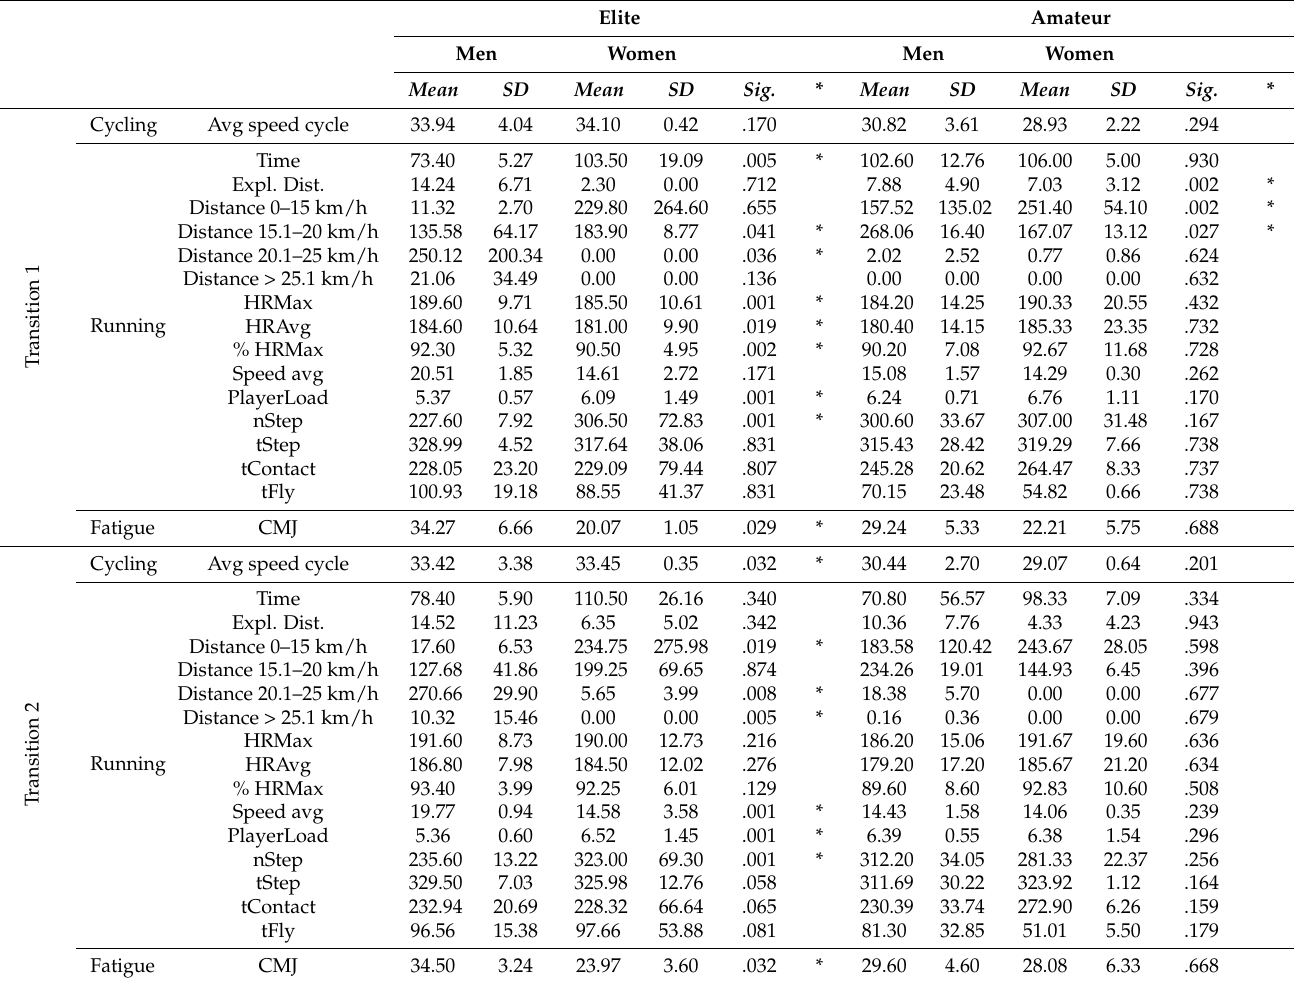
Table 3. Descriptive and inferential results of the variables analyzed based on the transition in circuit with